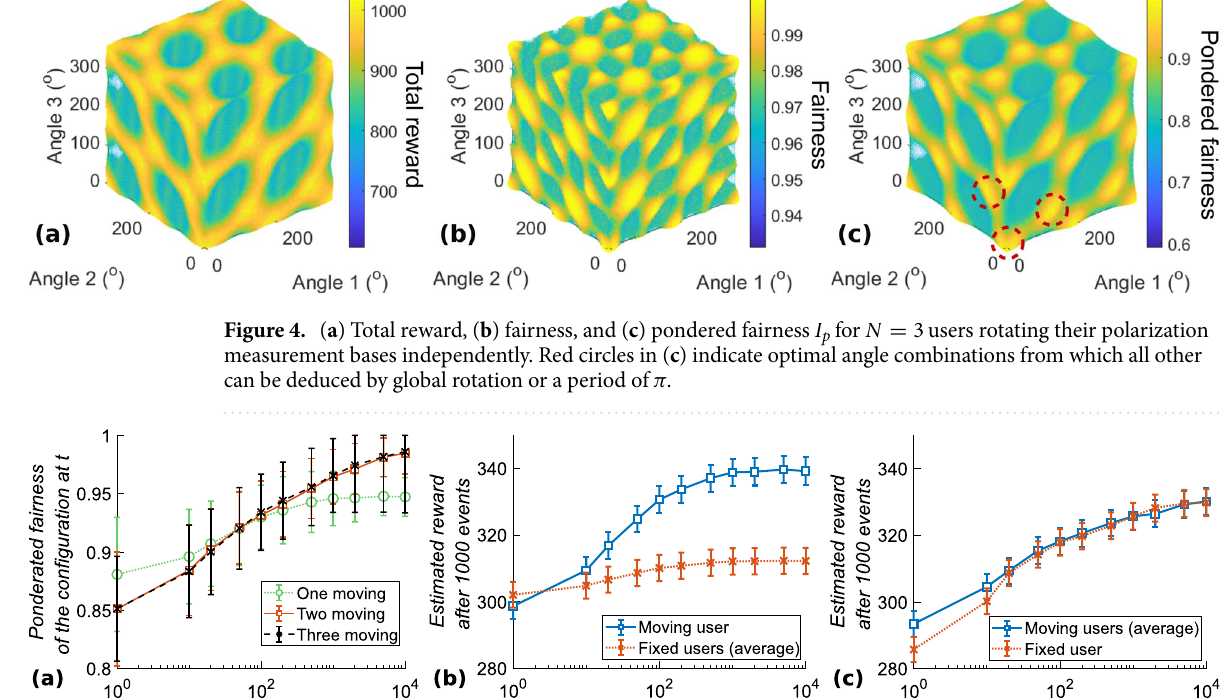
Figure 5. ( a ) Instantaneous pondered equality I p after different numbers of time steps t (log scale), when one (green), two (blue), or three (black) users react to misalignment. Estimated upcoming rewards for ( b ) one moving user (blue) and two fixed users (red) and ( c ) two moving users (blue) and one fixed user